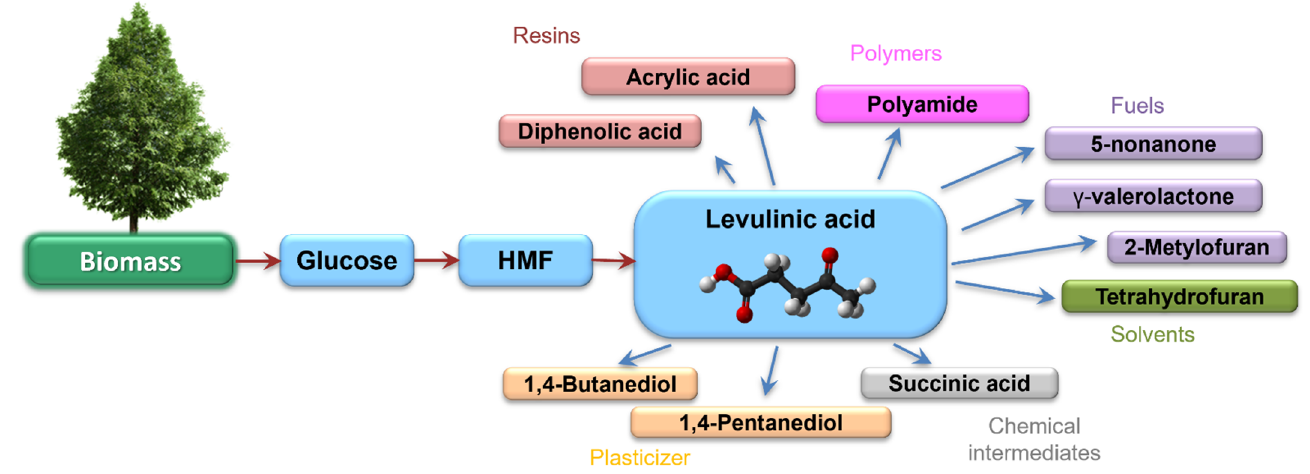
Figure 1. Scheme of reaction pathways of biomass into glucose and levulinic acid, as well as its further derivatives.